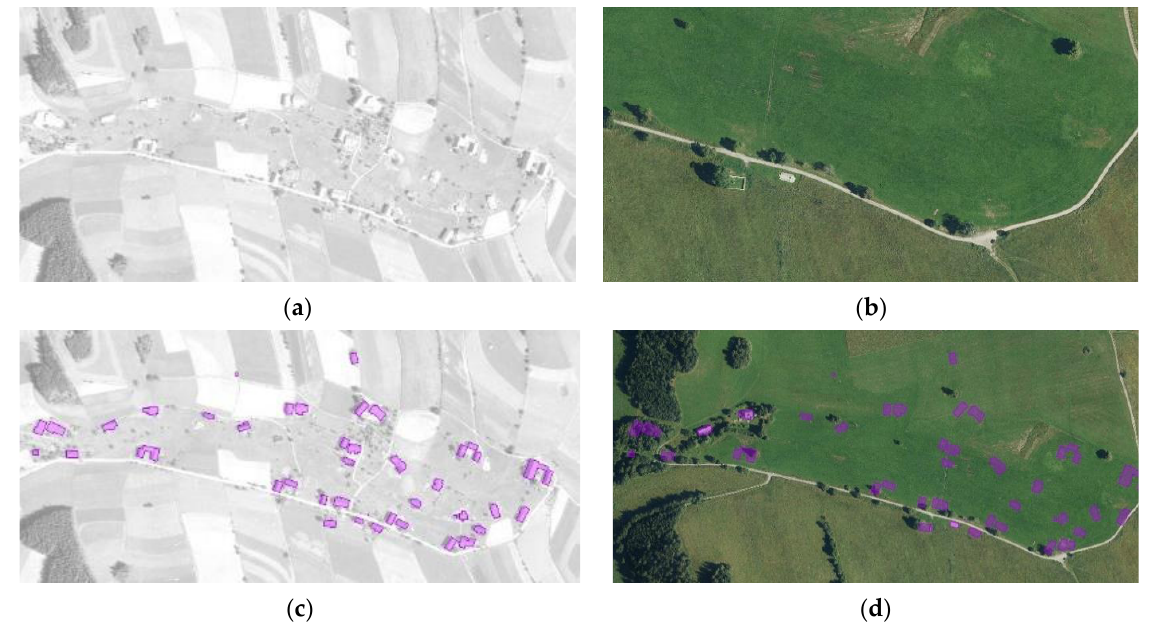
Figure 3. Identification of abandoned settlements based on the aerial survey images comparison: ( a ) aerial survey image (1946); ( b ) aerial survey image (2020); ( c , d ) marking the demolished buildings’ locations . Source: Ortofoto 2020 (© ČÚZK, www.cuzk.cz (accessed on 15 January 2020)), image 1946 —VGHMÚř Dobruška, © Ministry of Defense of the CR.